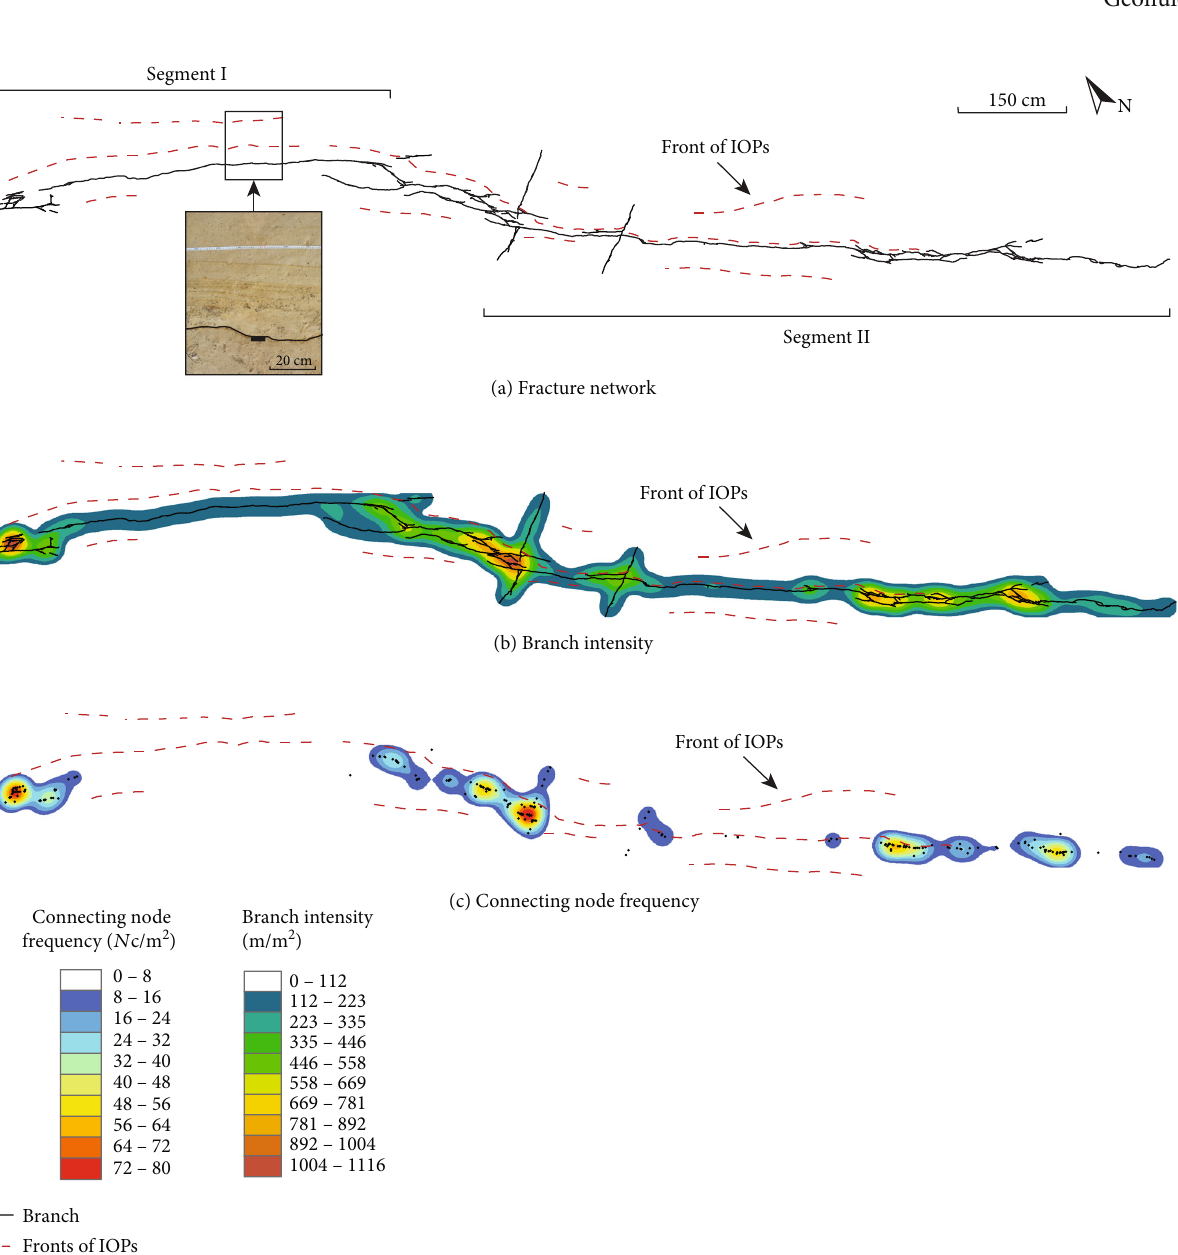
Figure 9: (a) Digitized map of the fracture network at Ras ir Raheb, Malta, with iron oxide precipitates shown as red dashed lines. (b) The branch intensity map indicates higher density in the areas of segment linkage. (c) Map of the connecting node frequency, which also increases in the areas where fault segments link indicating higher connectivity in linkage